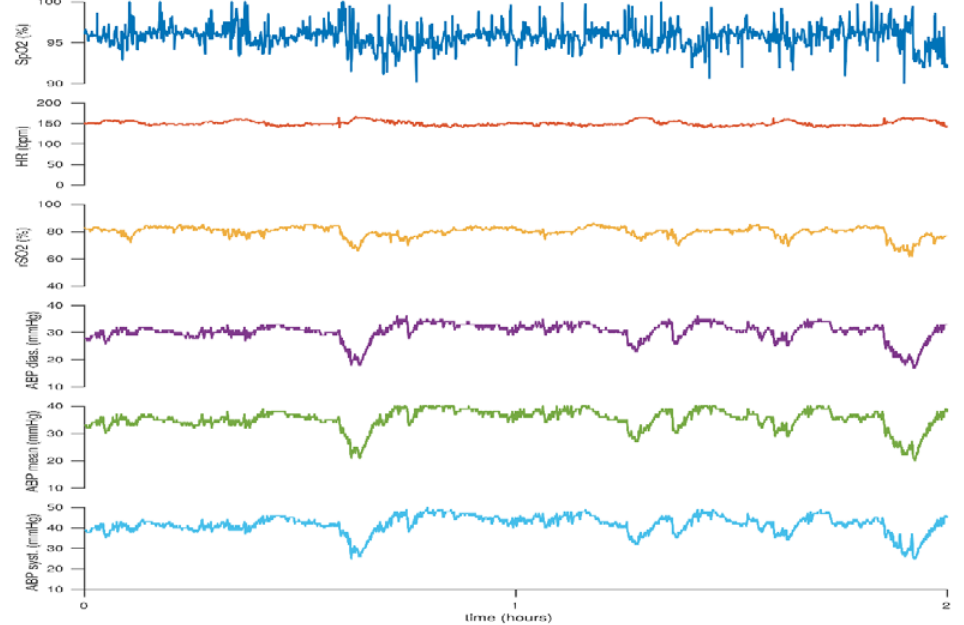
Figure 4. Decreases in cerebral rSO 2 in association with decreases in blood pressure. This figure reflects the case of a neonate born at 27 + 6 weeks gestation. BW 770 g, DOL 1.